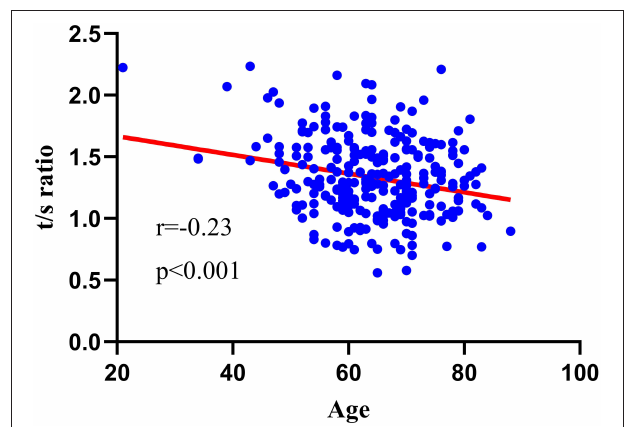
FIGURE 1 | Relationship between LTL and age. TLT was negatively associated with advanced age ( r = − 0.23, p <